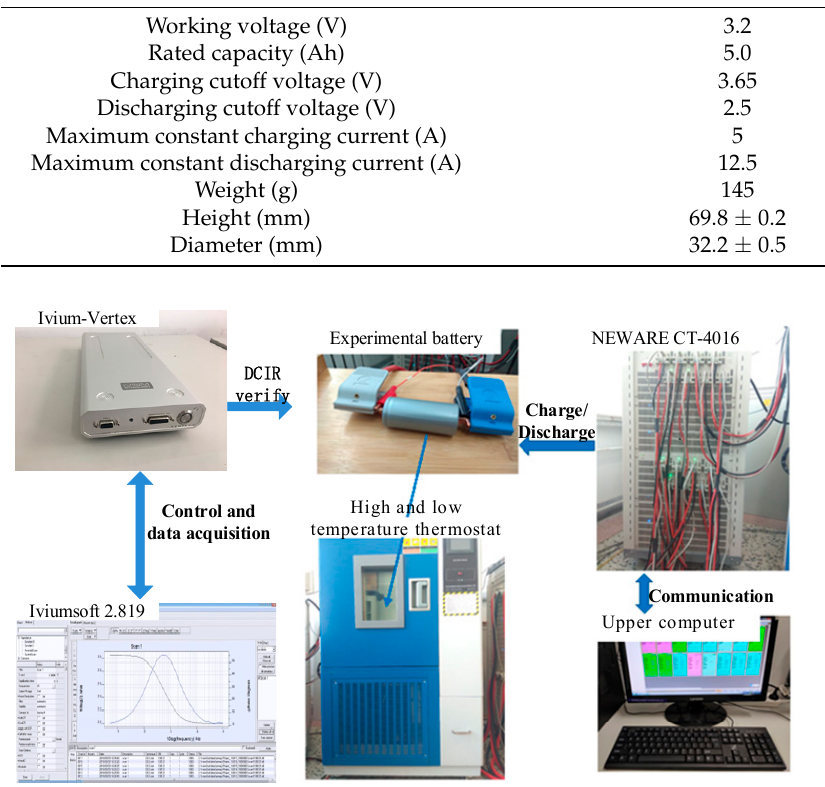
Figure 4. Experimental platform for evaluating the battery-aging characteristics.